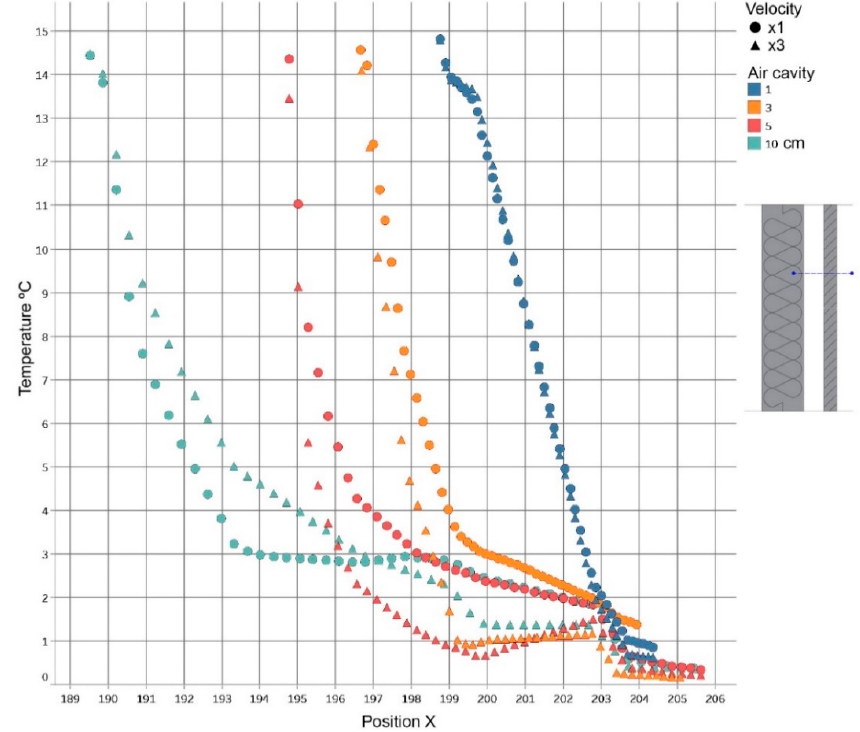
Figure 7. Temperatures in the air chamber, according to wind speed and chamber dimension.